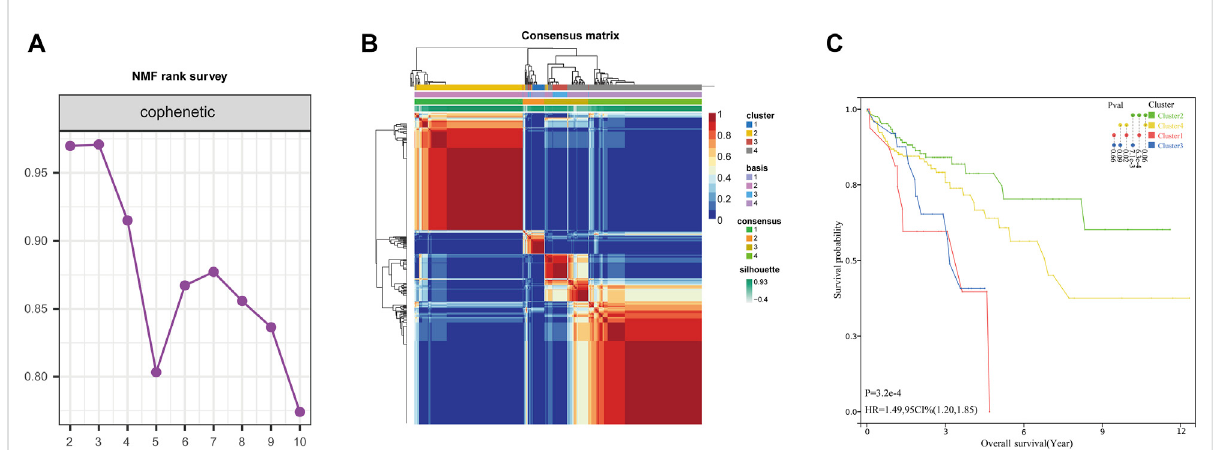
FIGURE 2 Identi fi cationofglycolysis- andlactate-relatedmolecularsubtypes. (A) ConsensusmapofNMFclustering. (B) Differentglycolysis-and lactate- related molecular subtypes of the TCGA cohort were identi fi ed for k = 4. (C) Survival analyses of the four clusters.